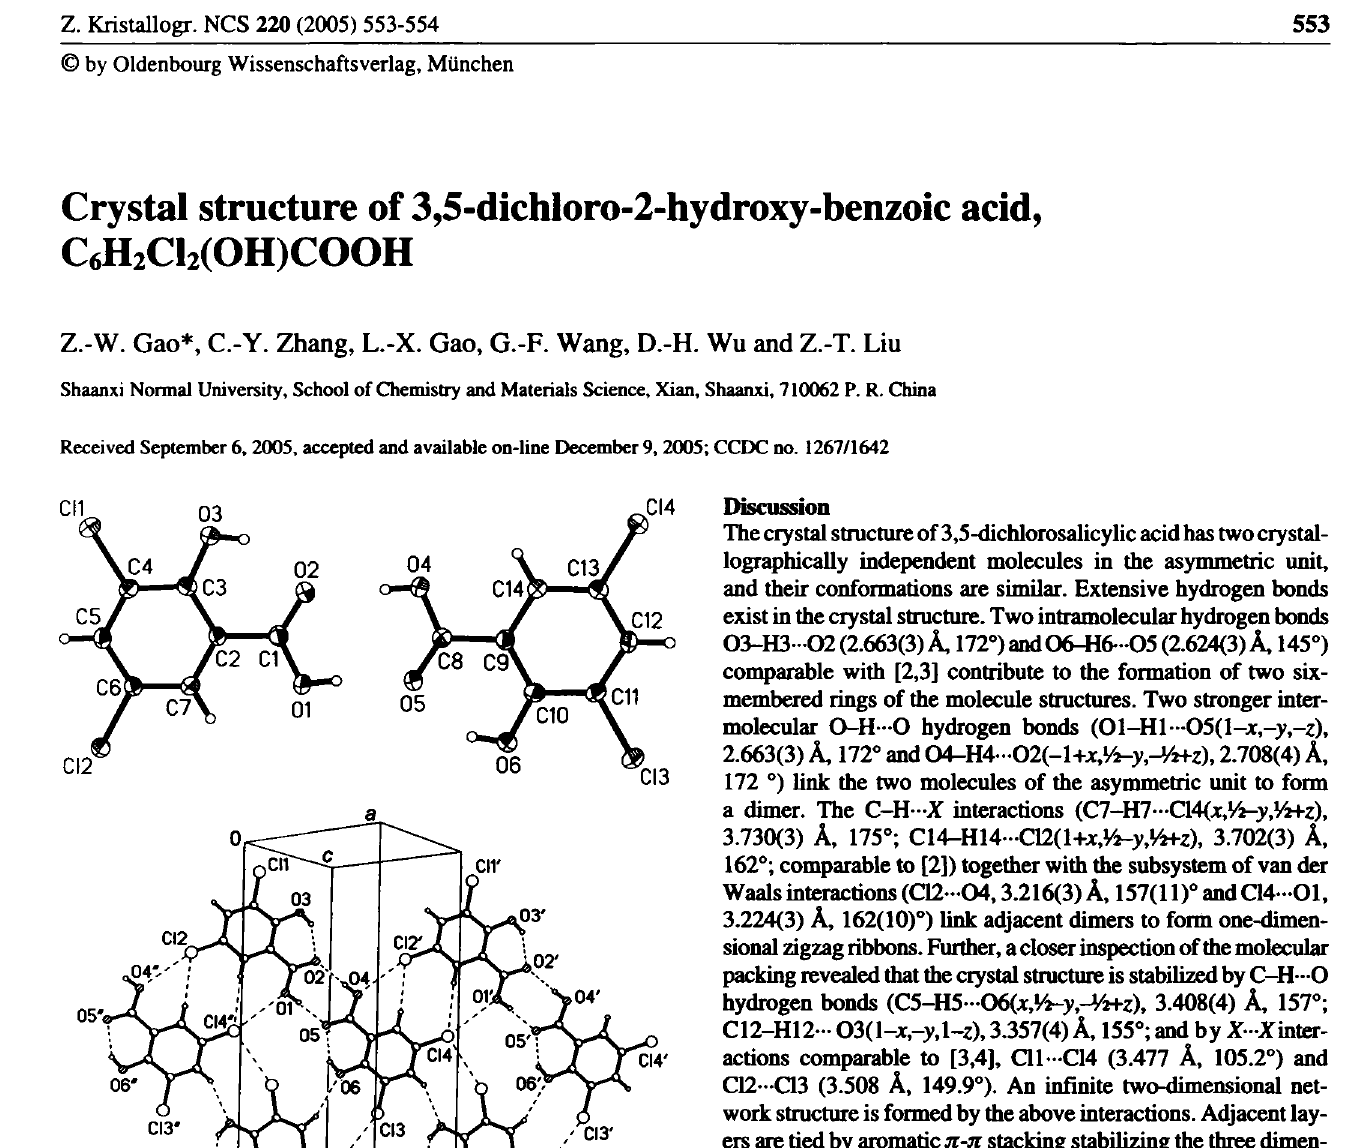
Table 1. Data collection and handling.